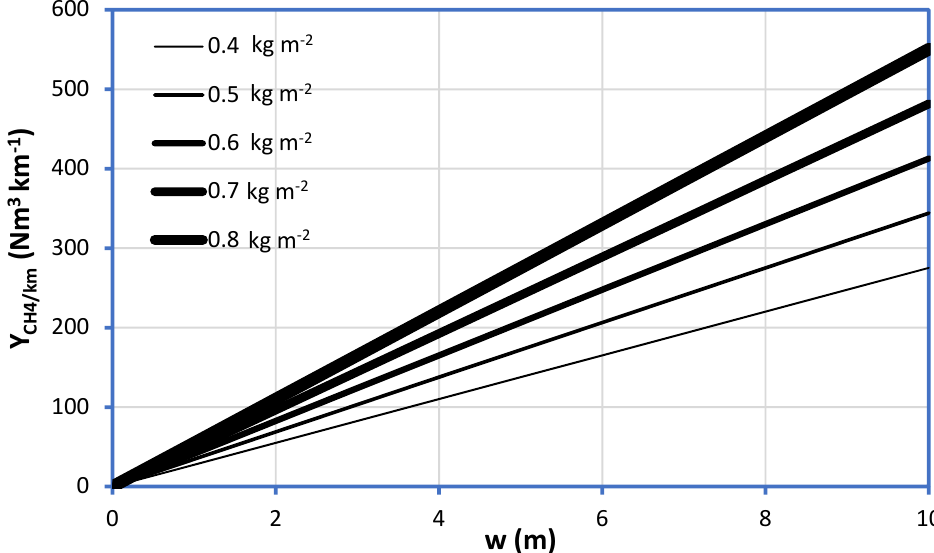
Figure 6. Methane yield per km of forest road as a function of the vertical distance (w) of pine needle litter collection on adjacent forest road and for different pine needle litter bulk densities.